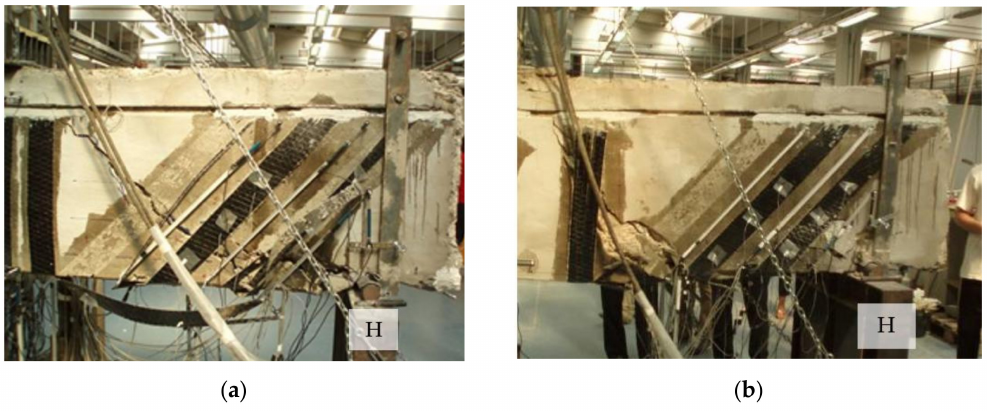
Figure 8. Damage on the beam DB1-R ( a ) and DB2-R ( b ) at support H after failure tests (back